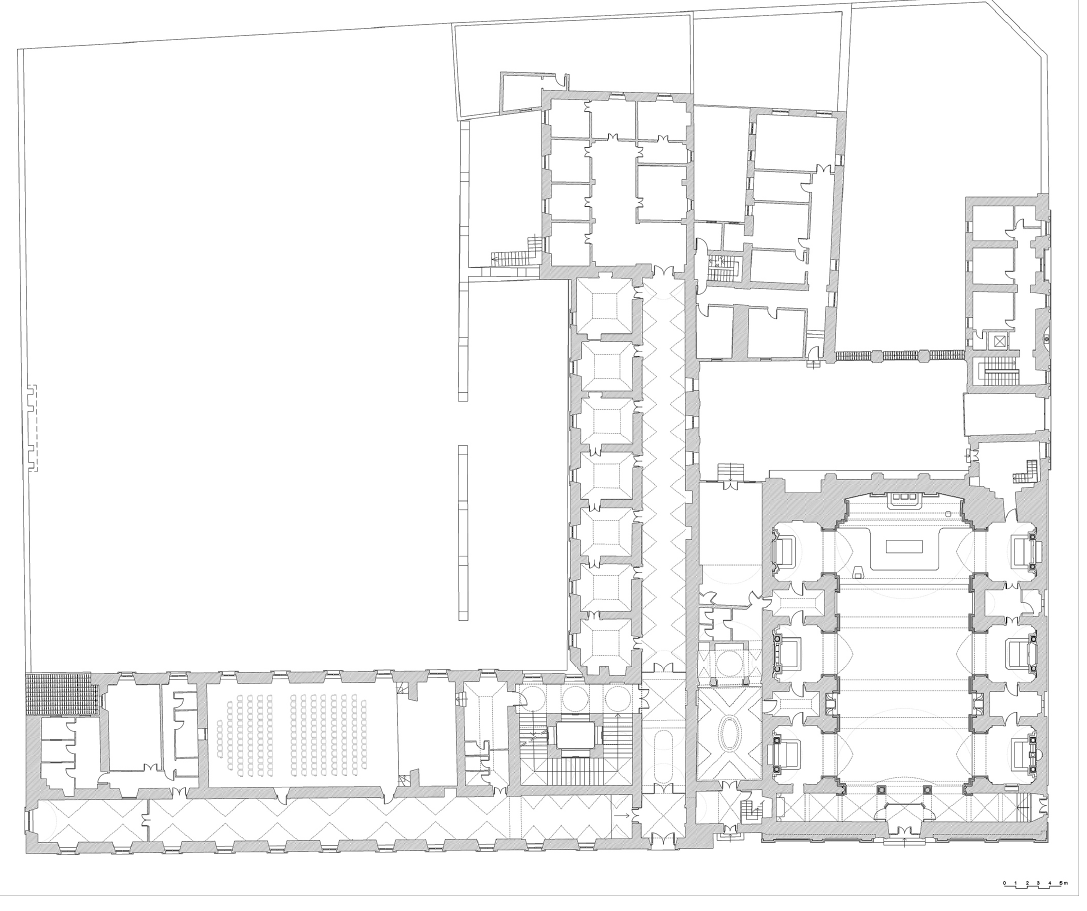
Figure 1. Plant of the Jesuit College with the Church of Santa